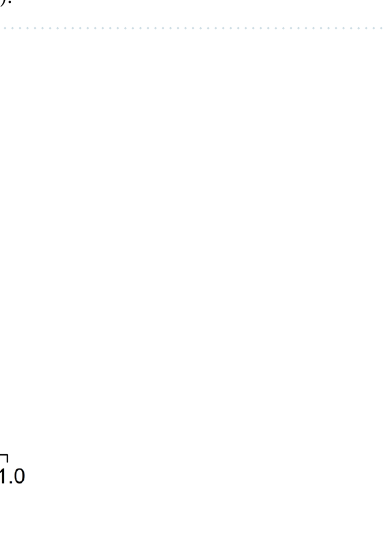
Figure 8. XPS spectra for Ti + TiO 2 /Al 2 O 3 + TiO 2 coating on LAE442 substrate: ( a ) C 1 s spectrum (A: C–C, B: C–OH + C–O–C, C: C = O, D: COOH, E: CO 3 2− ), ( b ) O 1 s spectrum (A: O-metal, B: O-C, C: H 2 O), ( c ) Cl 2 p spectrum (A: Cl-metal), ( d ) Ti 2 p spectrum (A: Ti 3+ –O, B: Ti 4+ –O).